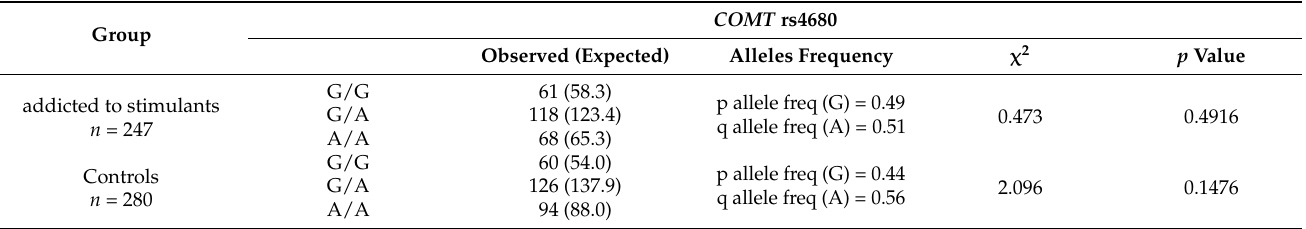
Table 2. Hardy-Weinberg equilibrium of the COMT rs4680 in a group of subjects with a diagnosis of other stimulants dependence and